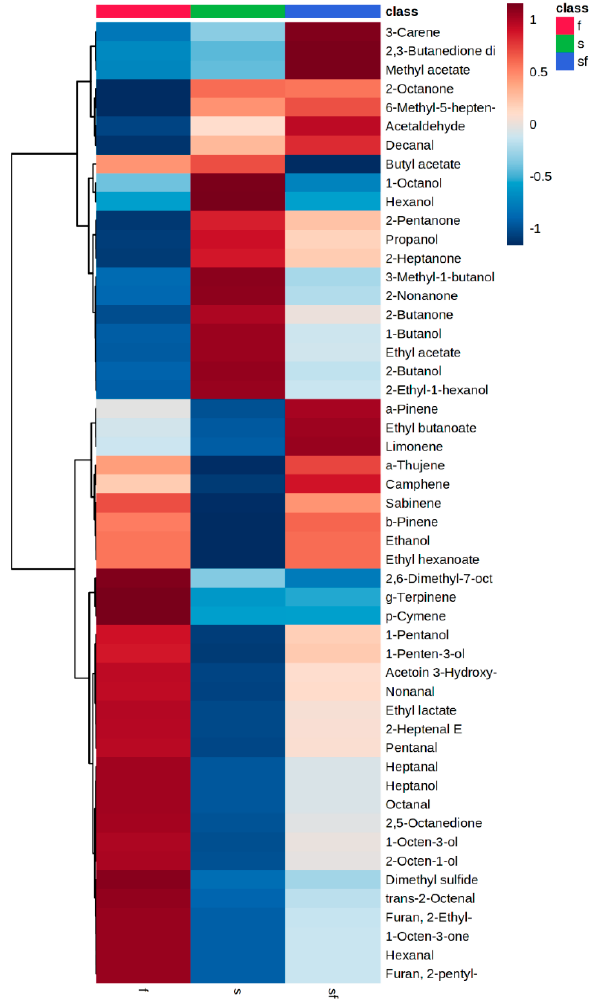
Figure 5. Heatmap of the volatiles clustered into 3 sensory classes of the sterile and inoculated meat samples during storage at 4 and 10 °C. Ward-linkage clustering was based on the Euclidean correlation coefficients of the 51 volatiles identified in the different sensory classes. The color scale represents the scaled abundance of each variable, with red indicating high abundance and blue indicating low abundance. Columns are colored according to the sensory class: fresh (red), semi-fresh (blue) and spoiled (green).